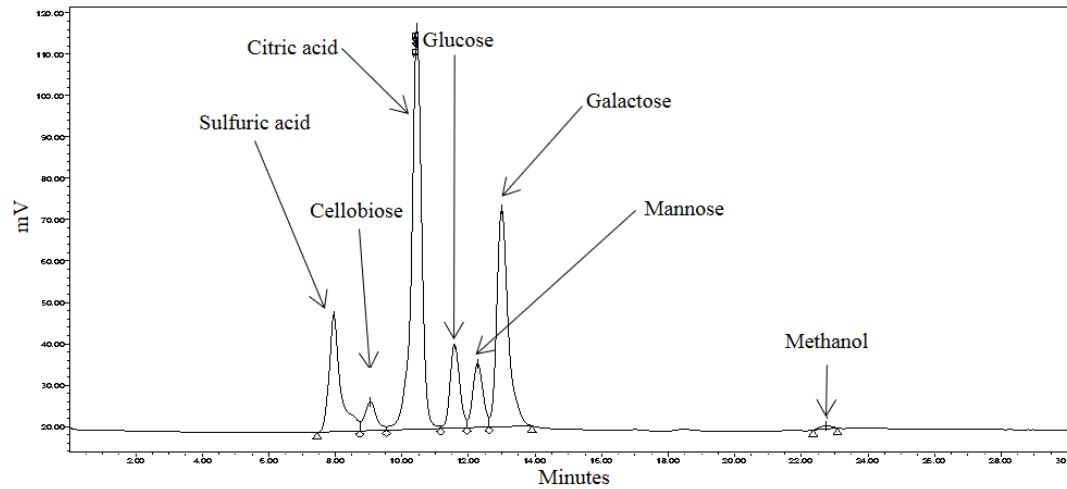
Figure 7. HPLC chromatogram of pretreated spent coffee waste sample.